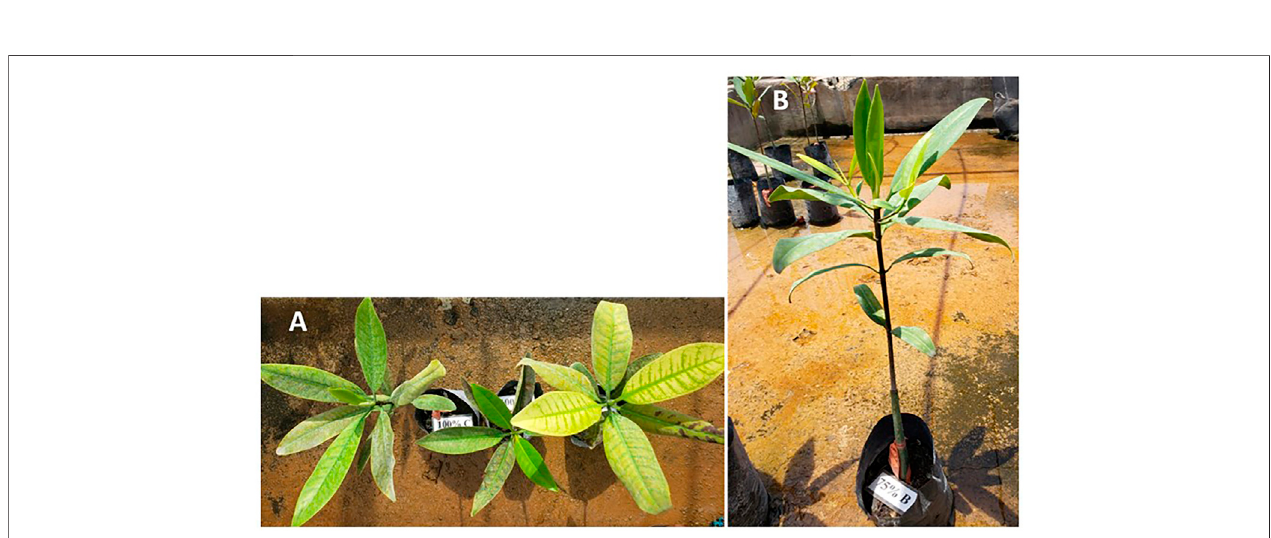
FIGURE 4 | R. mangle seedlings showing leaf damage after growth in 100% SC (A) and seedlings in 75% SC showing lateral branching (B) . Lateral branching observed at the end of the experiment.